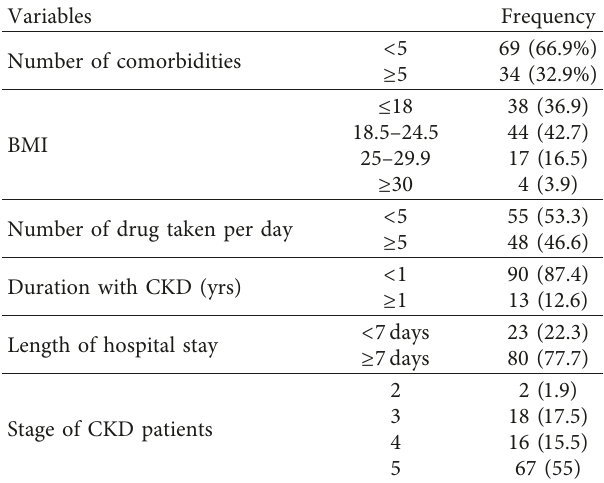
Table 2: Clinical characteristics of CKD patients at JUMC, Jimma Zone, Jimma, Southwest Ethiopia, from April 01 to September 30,